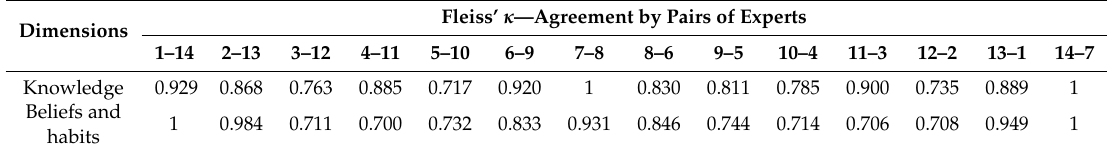
Table 5. Agreement by pairs of